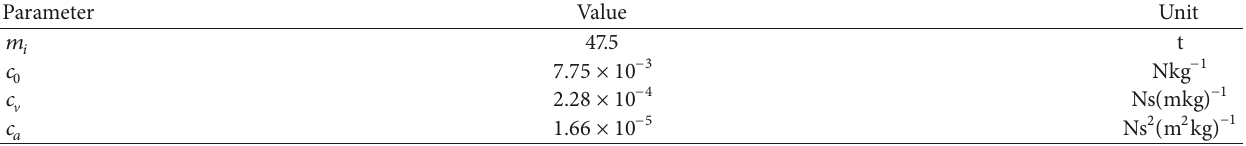
Table 1: The basic resistance parameters of Chinese electric multiple units high-speed train CRH3.